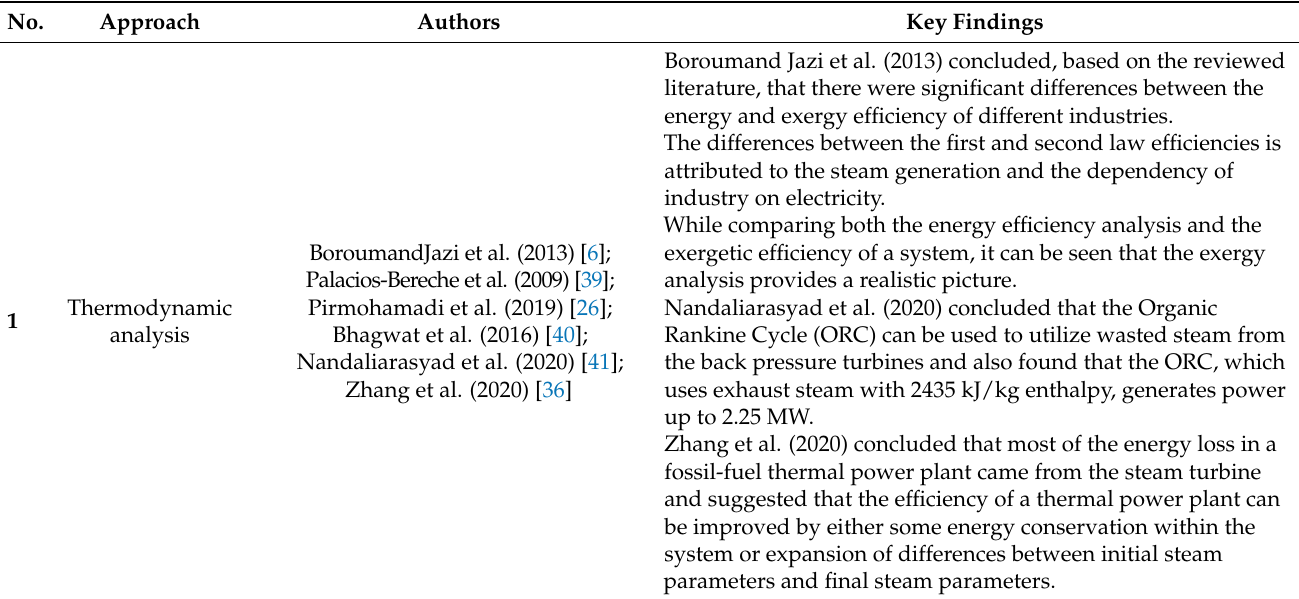
Table 2. Examples of the 3 main case study